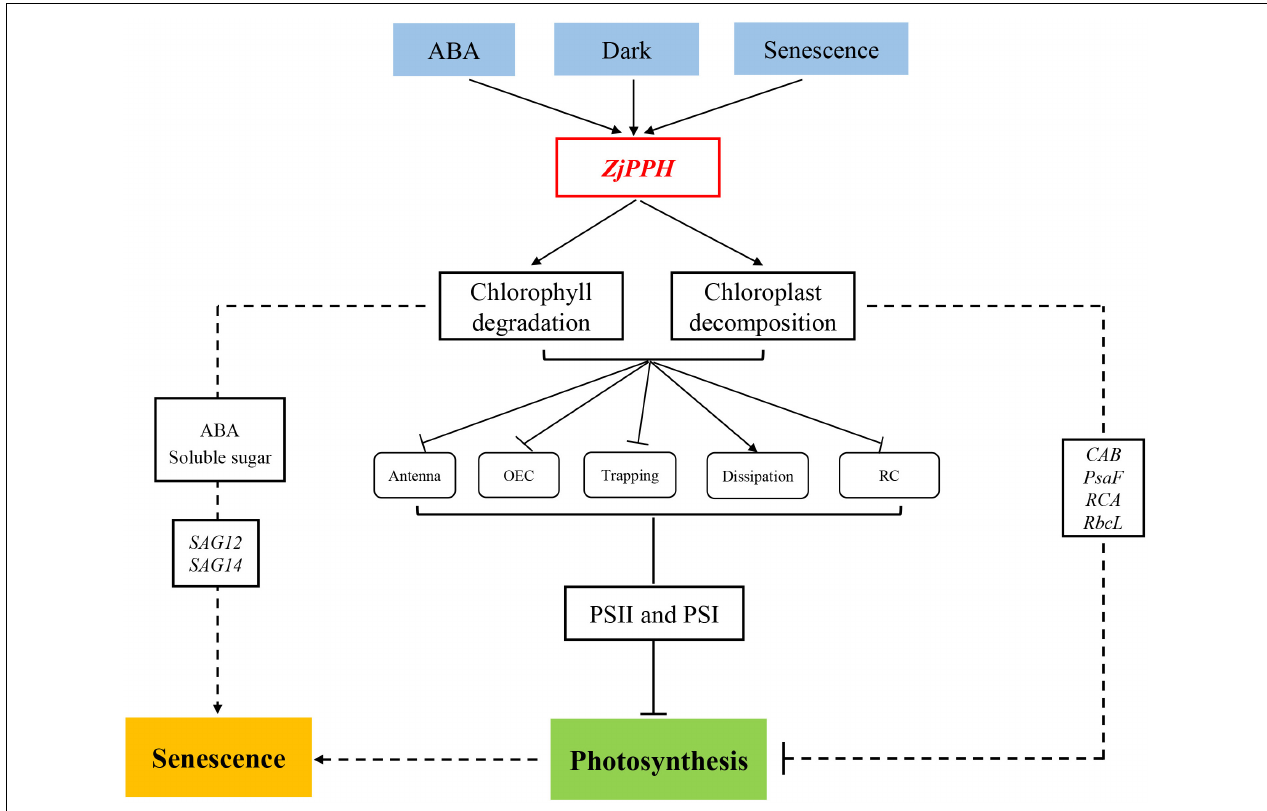
FIGURE 9 | Proposed model of the molecular regulating machinery of ZjPPH in senescence and